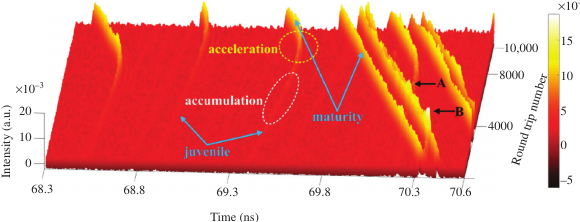
Figure 5: The spatio-temporal evolution of the deuterogenic